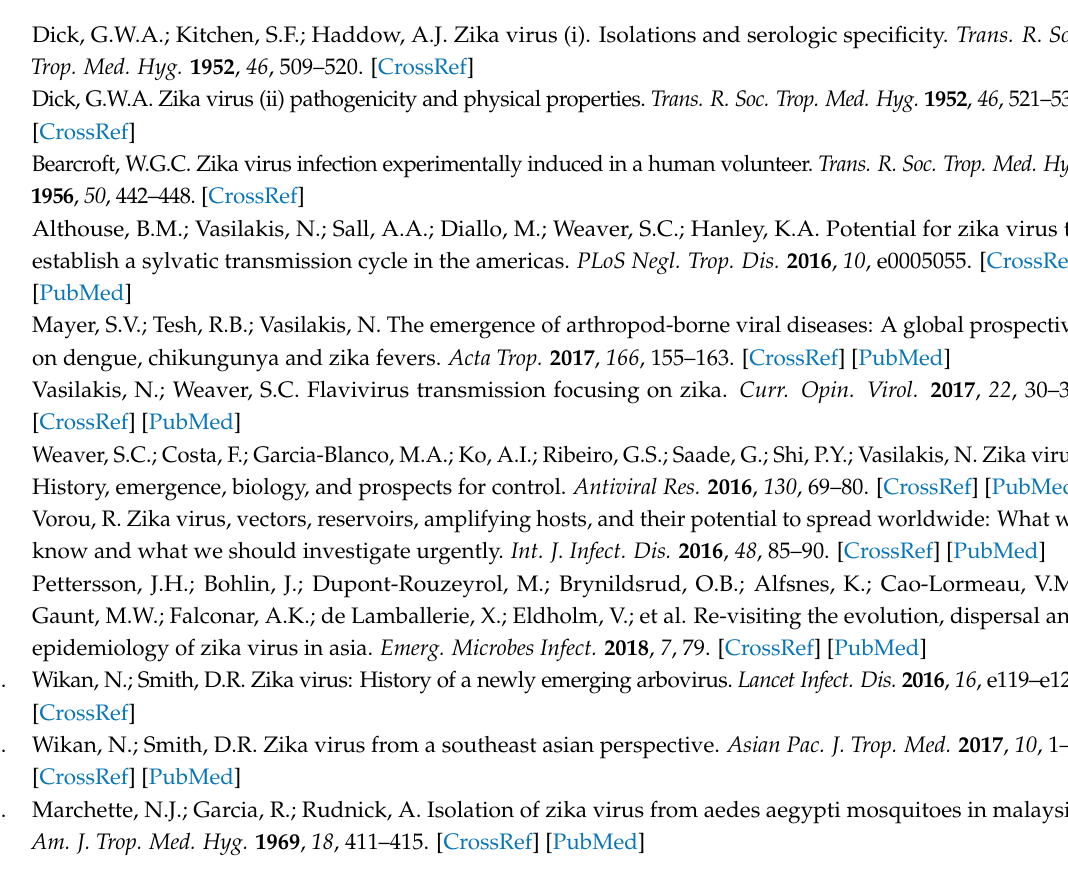
Figure S1: Sera was analyzed on Abaxis Comprehensive Diagnostic Profile rotors utilizing the VetScan VS2 system. Figure S2. Whole blood collected in K 2 EDTA tubes was utilized to perform CBC using the HemaVet 950